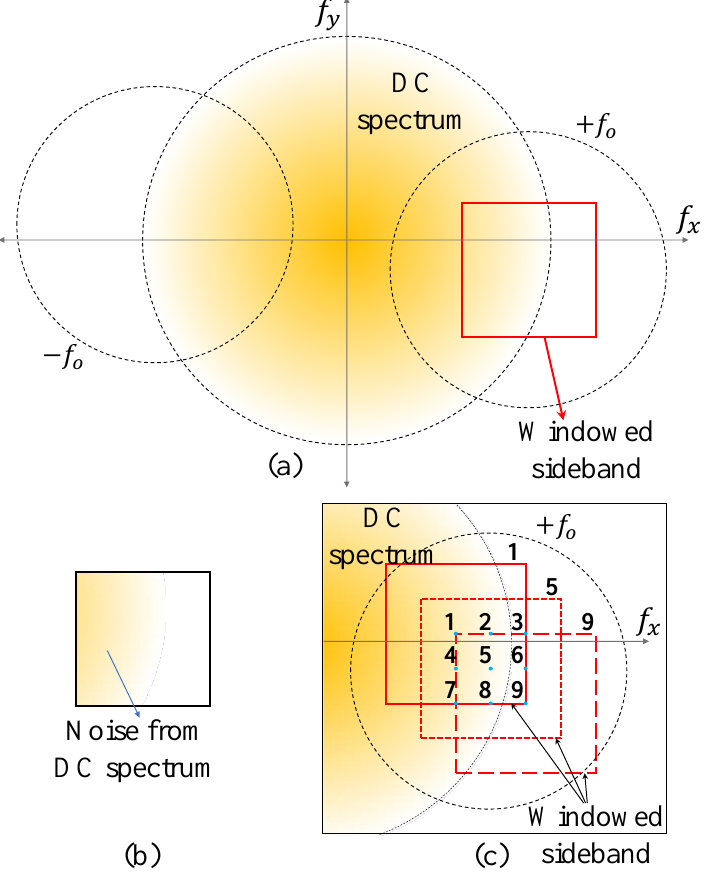
Figure 1. Image processing of DHM ( a ) windowing sidebands from the 2D Fourier domain of the recorded hologram, ( b ) windowed sideband as a red solid square of ( a , c ) the proposed